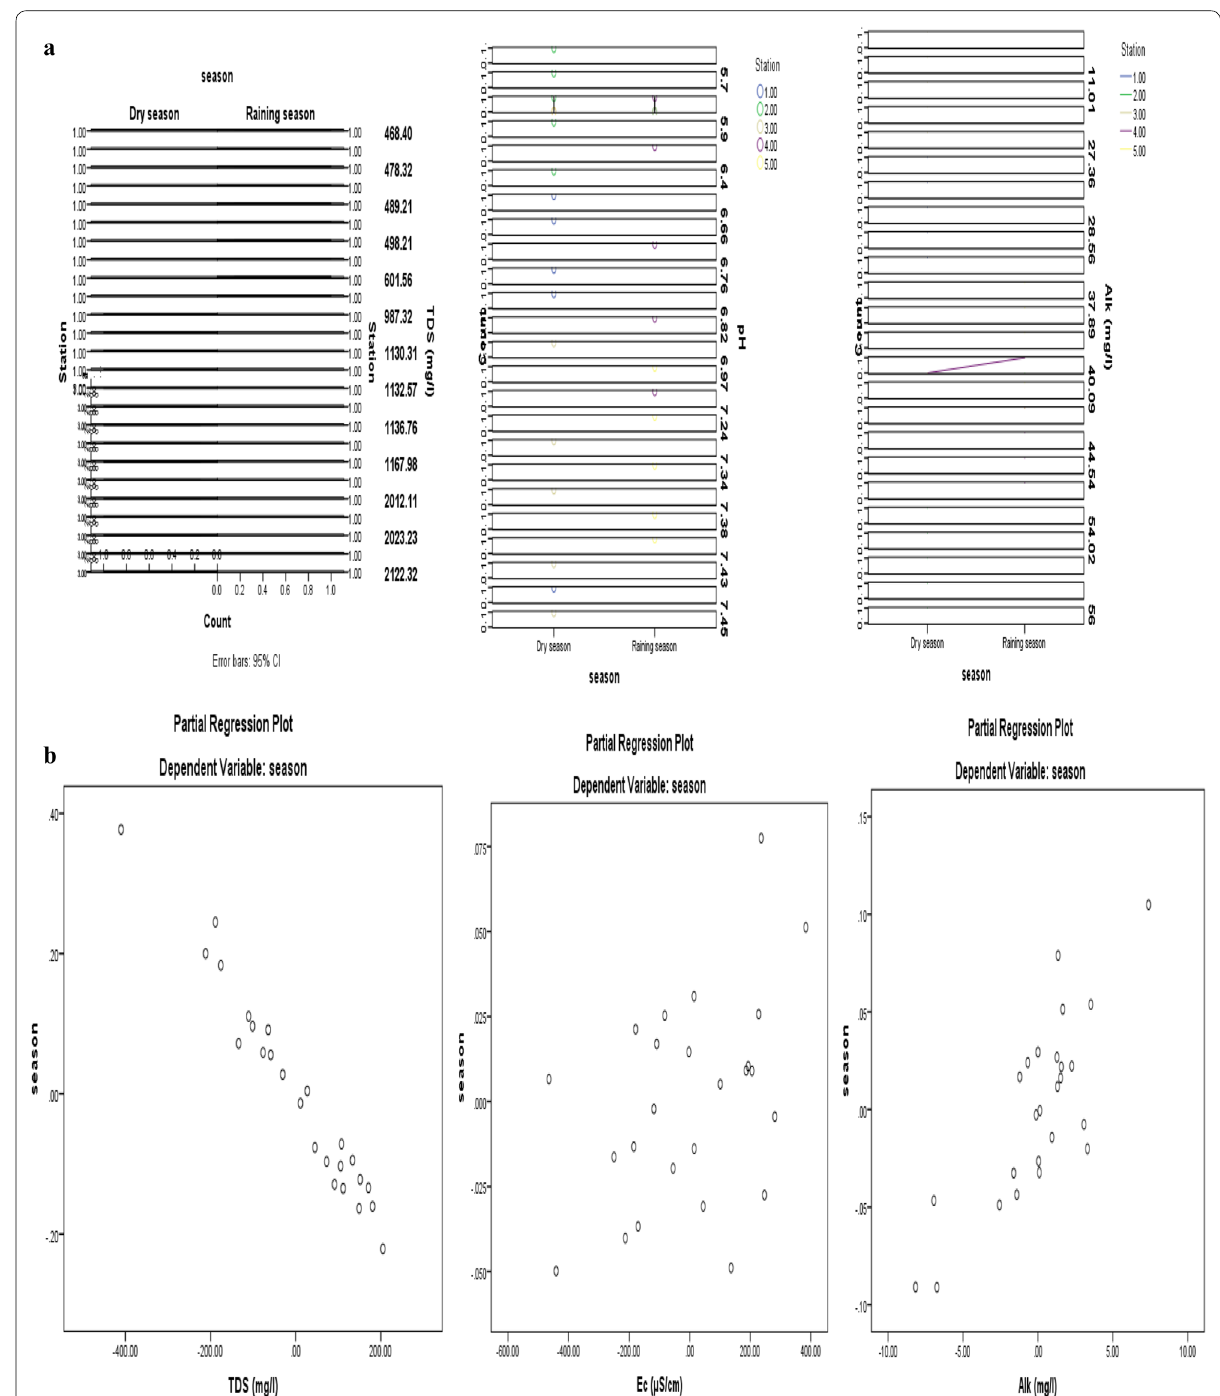
Fig. 4 a X graph of TDS, TH and Alk. b Partial regression plot of TDS, EC and